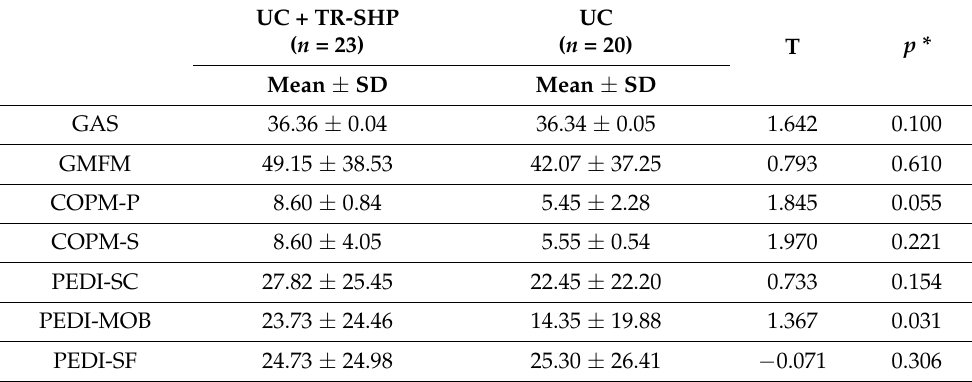
Table 3. Initial characteristics of groups determined by measurement.